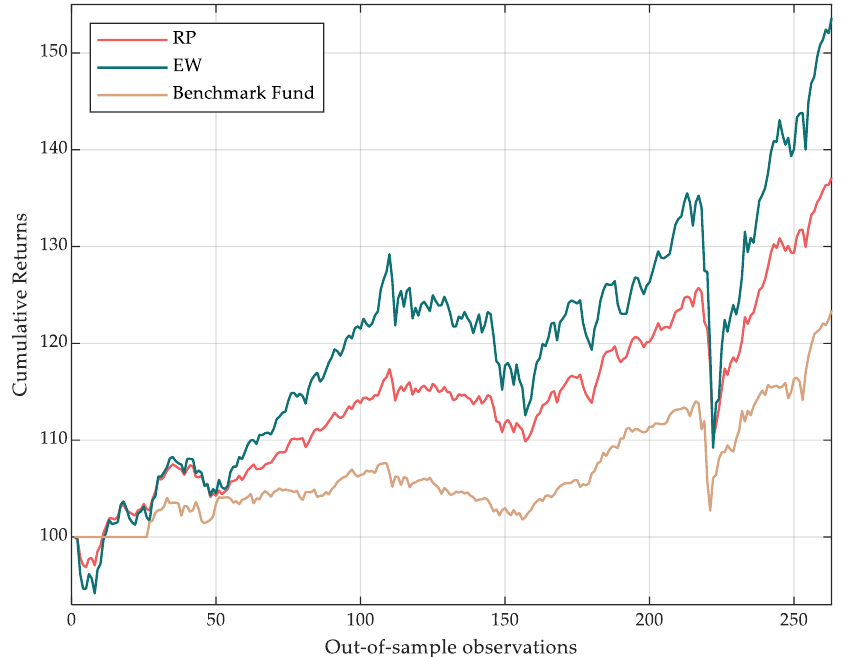
Figure 5. Combined Portfolio returns (in-sample w = 244; out-of-sample w = 262). Note: to improve table clarity, returns were normalised on a scale of 100.